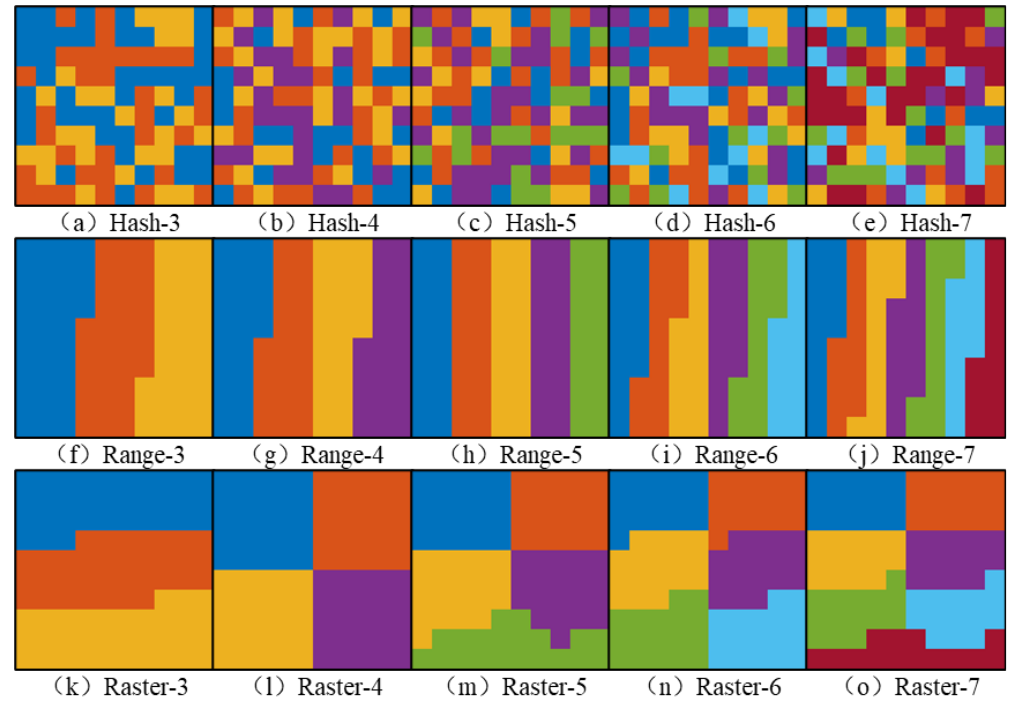
Figure 12. The partition results for the hash, range and raster partition methods over the 10 × 10- image layout.